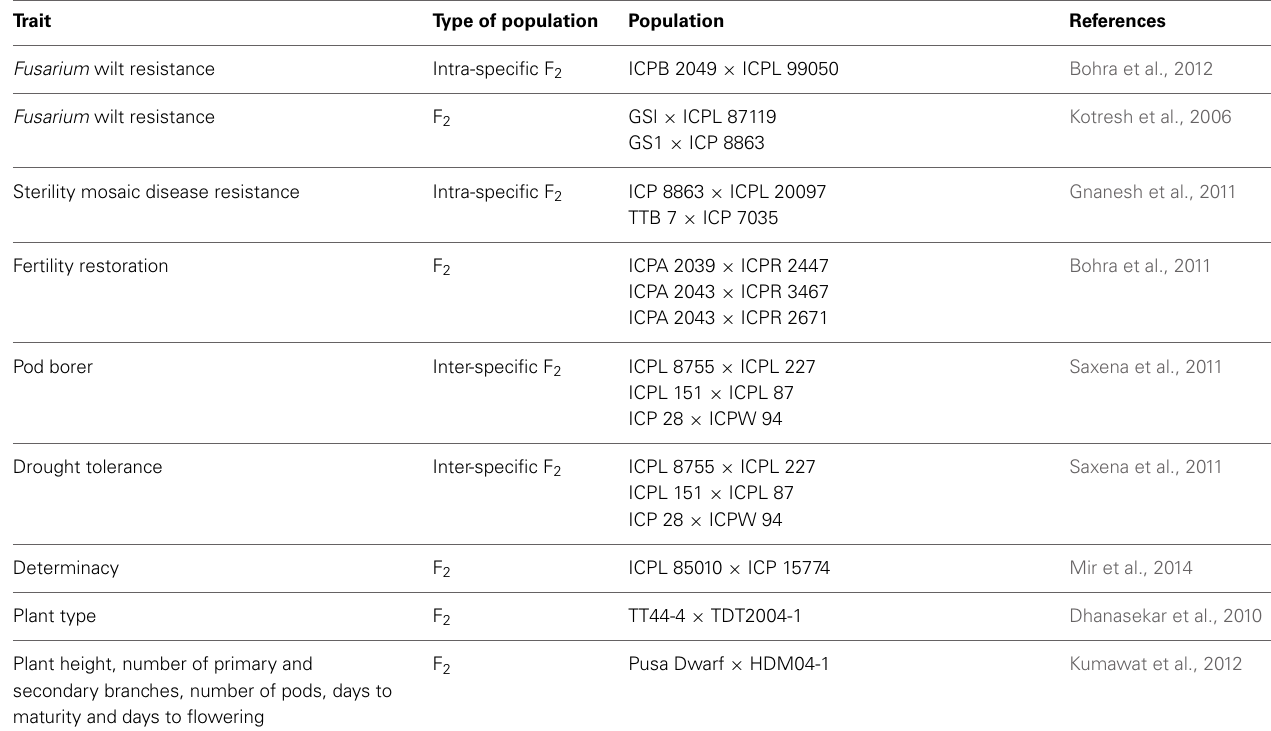
Table 2 | Genetic resources available for mapping different traits in